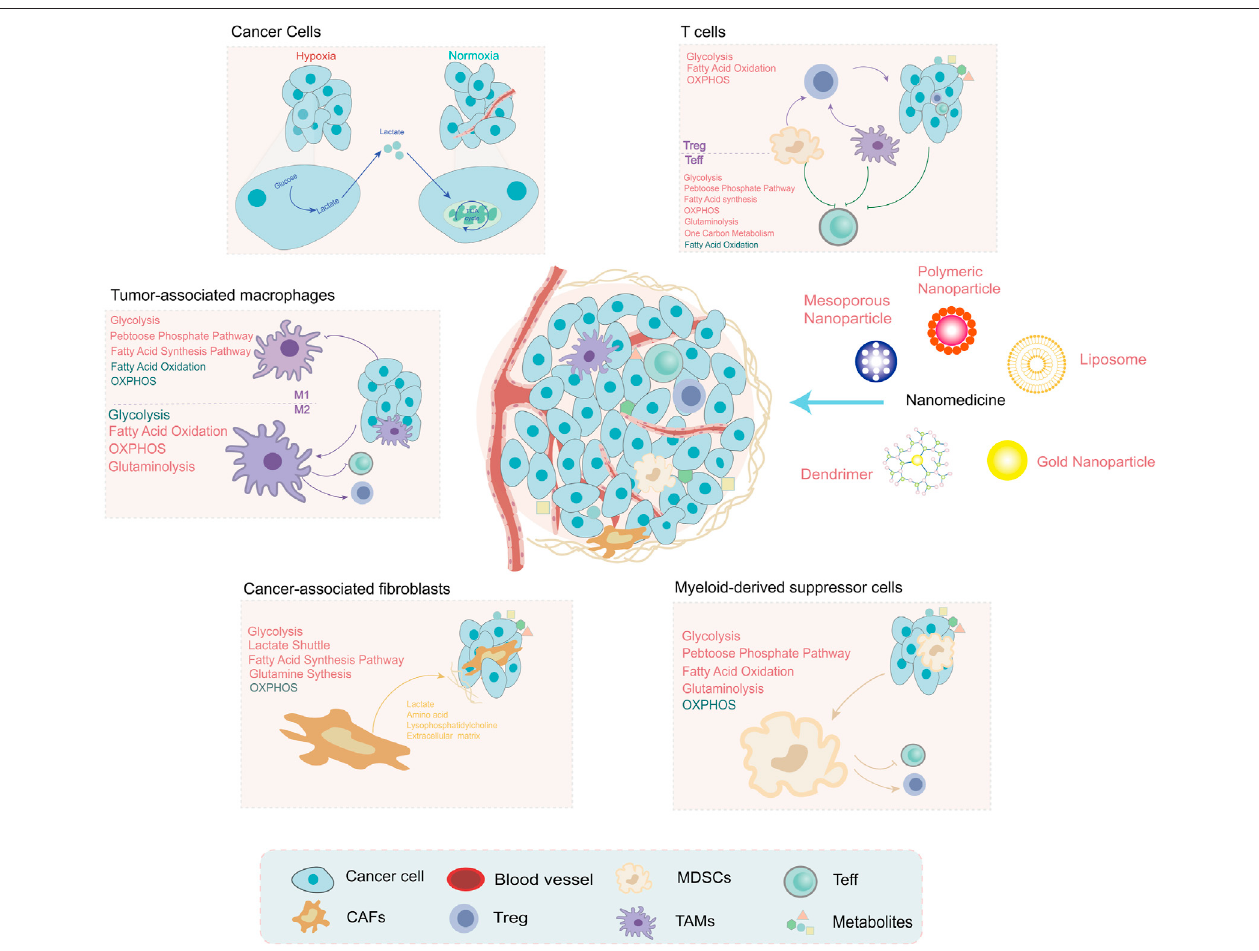
FIGURE 2 | The metabolites are shaped by noncancer cells within the tumor microenvironment (TME), which have unique metabolic pro fi les and vulnerabilities. Under hypoxia conditions, the metabolites produced by tumor cells are regulators of noncancer cell function, such as lactate and PGE2. The metabolic pathway alterations of noncancer cells within TME are depicted in different colors (red: upregulation and green: downregulation). These alterations provide a promising direction for the development of nanomedicine: targeting metabolism to improve the TME for cancer treatment.